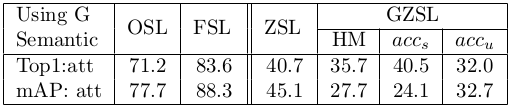
Table from the paper: A Unified approach for Conventional Zero-shot, Generalized Zero-shot and Few-shot Learning
Table text:
UsingG
OSL
FSL
ZSL
GZSL
Semantic
HM
acc s
acc u
Top1:att
71.2
83.6
40.7
35.7
40.5
32.0
mAP:att
77.7
88.3
45.1
27.7
24.1
32.7